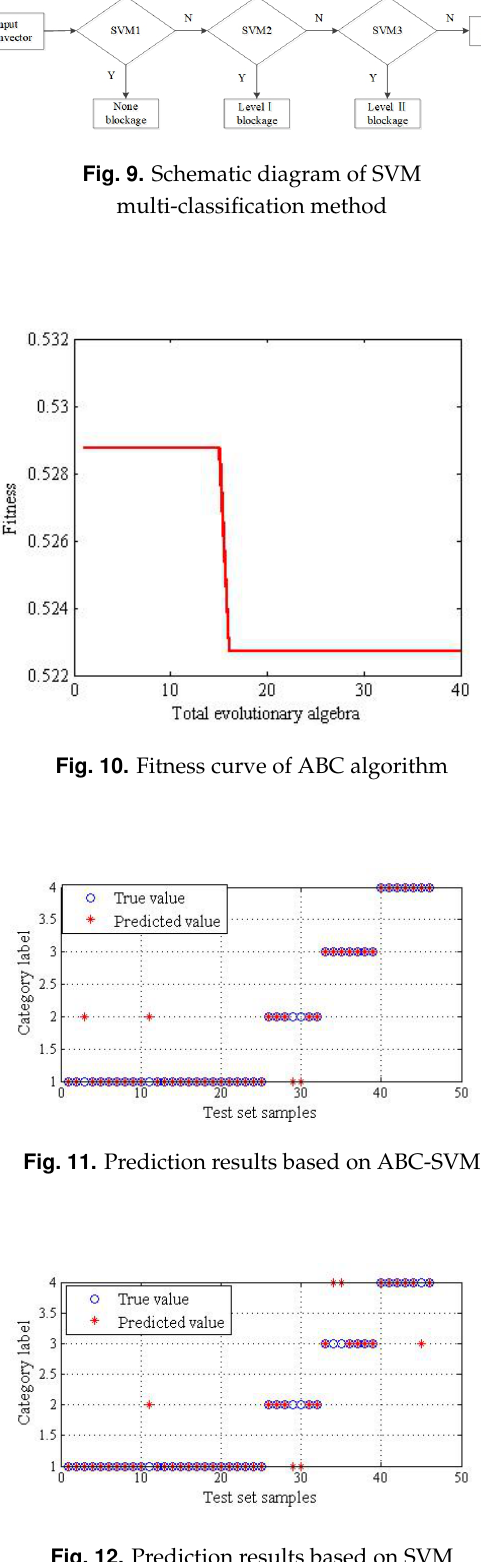
Fig. 12. Prediction results based on SVM